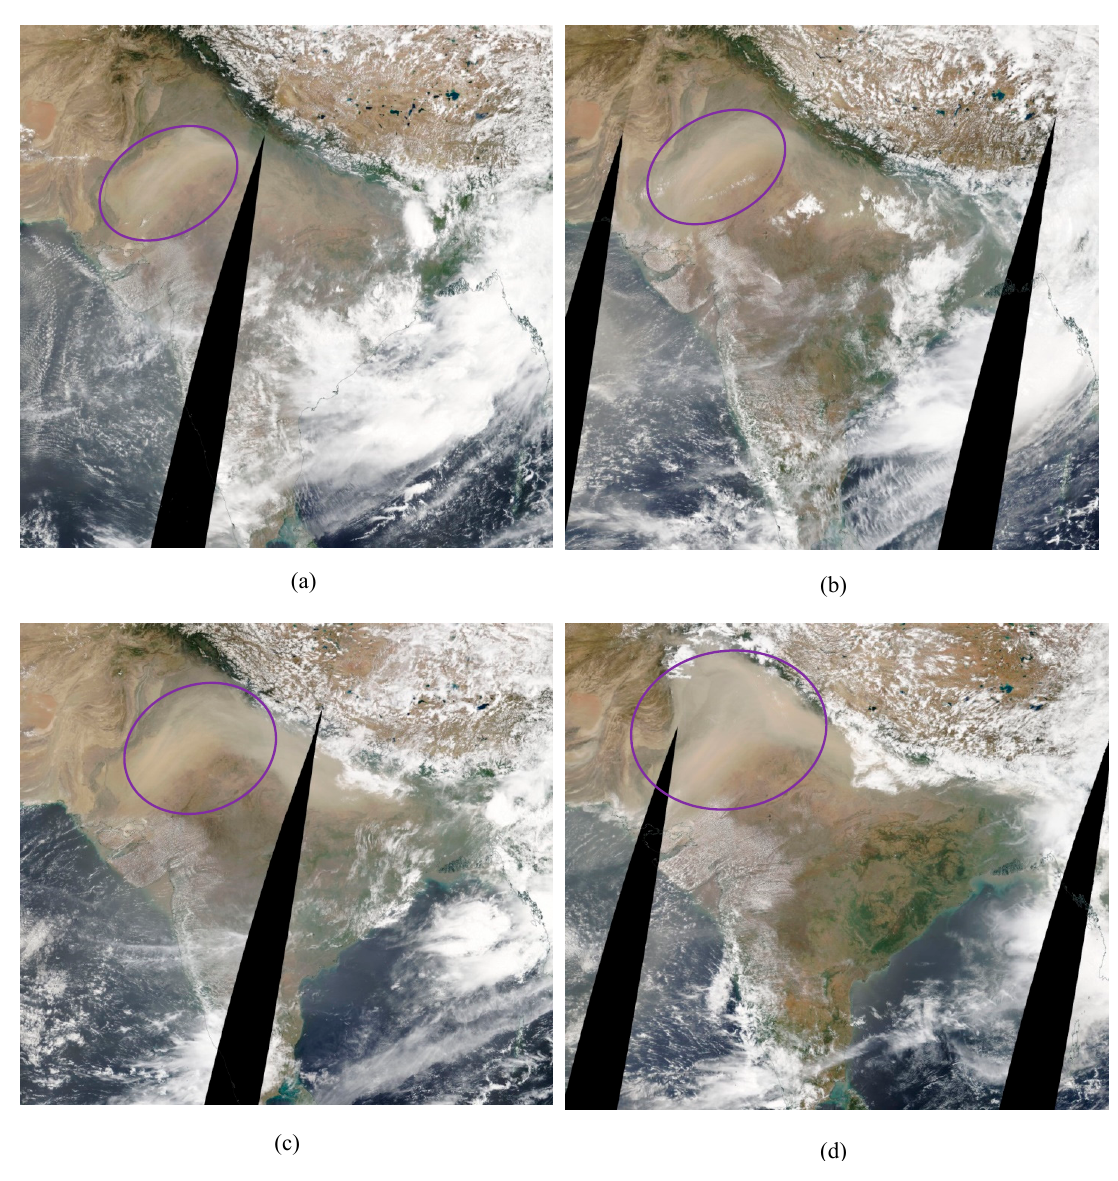
Figure 3. Dust storms images captured by moderate resolution imaging spectroradiometer (MODIS) / Terra (1 km resolution) on 12–15 June 2018 (( a – d ), respectively [26]). Pink colored circles area show the dust plume areas of western to northwestern to northern parts of India.